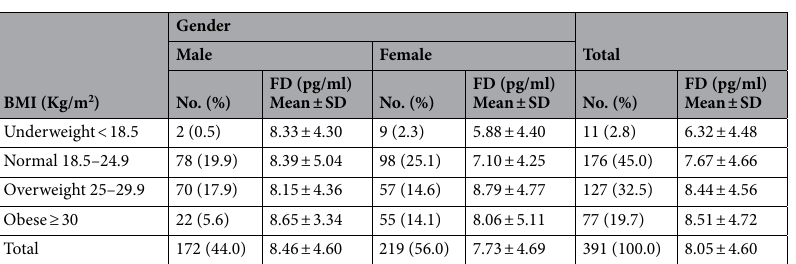
Table 6. Mean and standard deviation of Free 25-OHD level in respect to BMI.